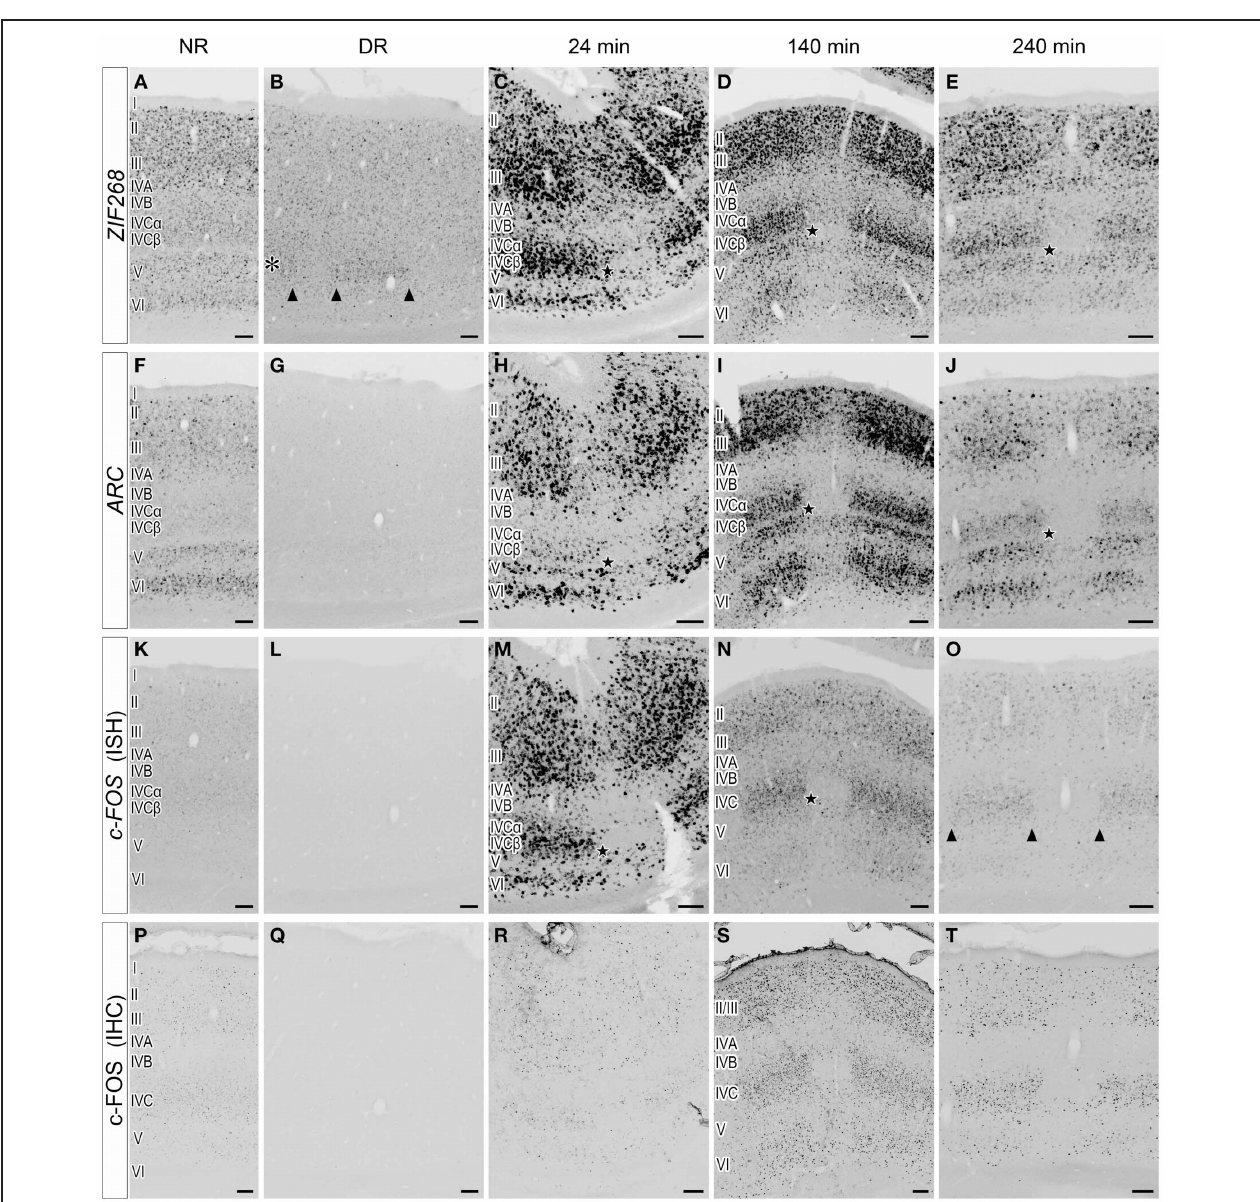
FIGURE 5 | Laminar distribution of IEG mRNA expression in V1 induced by monocular light stimulation. (A–O) Expressions of ZIF268 (A–E) , ARC (F–J) , and c-FOS (K–O) mRNAs in V1. Twenty-four minutes (C,H,M) , 140min (D,I,N) , and 240min (E,J,O) after monocular light induction as in Figure 1B . (B,G,L) Dark-reared animals (DR) as in Figure 1A . (A,F,K) Normal-reared animals (NR) as in Figure 1C . Adjacent sections were analyzed by the probe of the indicated gene under each condition. The asterisk in panel (B) indicates